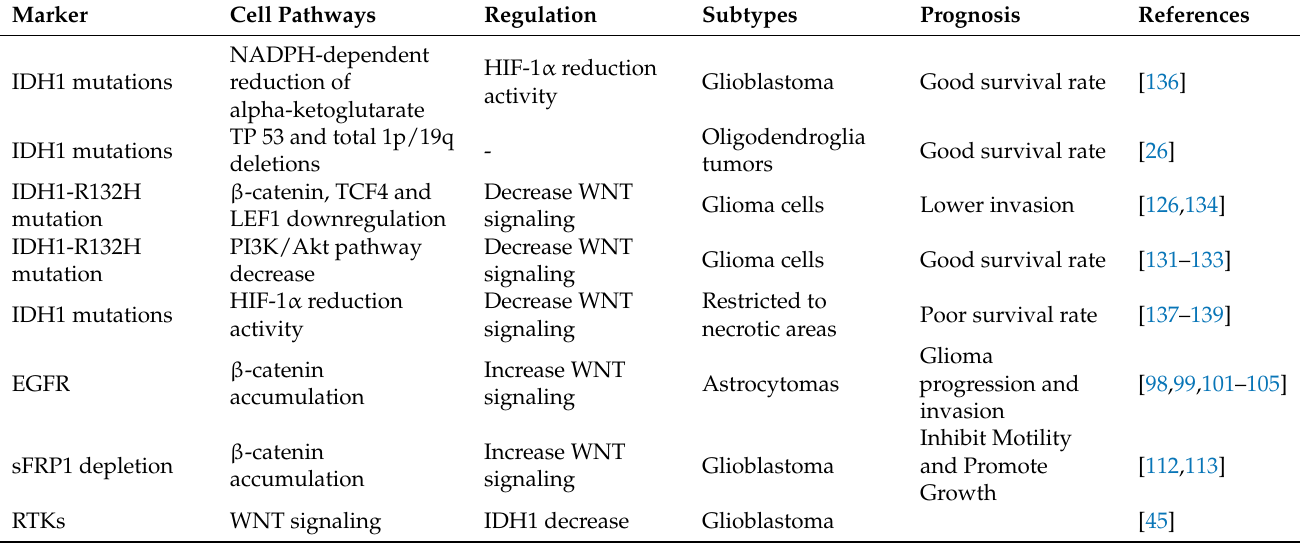
Table 1. Opposed interplay between the WNT pathway and IDH1 mutations and the involved molecular targets.